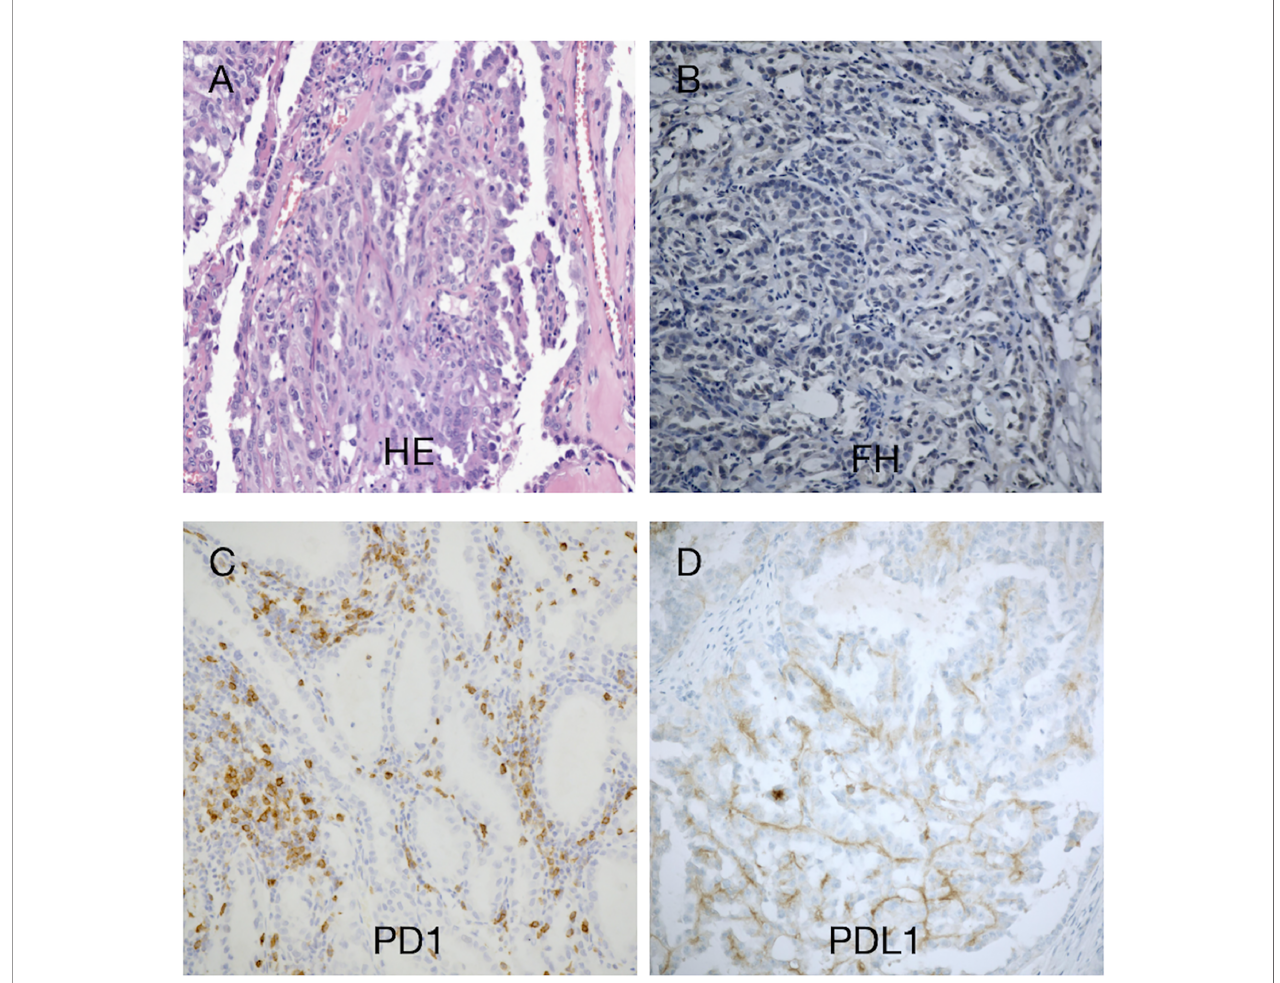
FIGURE 2 | Histomorphological fi ndings in our patient with hereditary leiomyomatosis and renal cell cancer syndrome. (A) Hematoxylin – eosin staining showed a renal cell carcinoma with papillary and tubular structures. (B) Immunohistochemistry revealed absence of fumarate hydratase (FH) expression in tumor cells, supporting the diagnosis of FH-de fi cient RCC. (C, D) There were few tumor-in fi ltrating lymphocytes (TILs). Approximately 30% of the tumor cells exhibited programmed cell death-ligand 1 (PD-L1) expression. TILs exhibited programmed cell death-1 (PD-1) expression (35%). Magni fi cation,